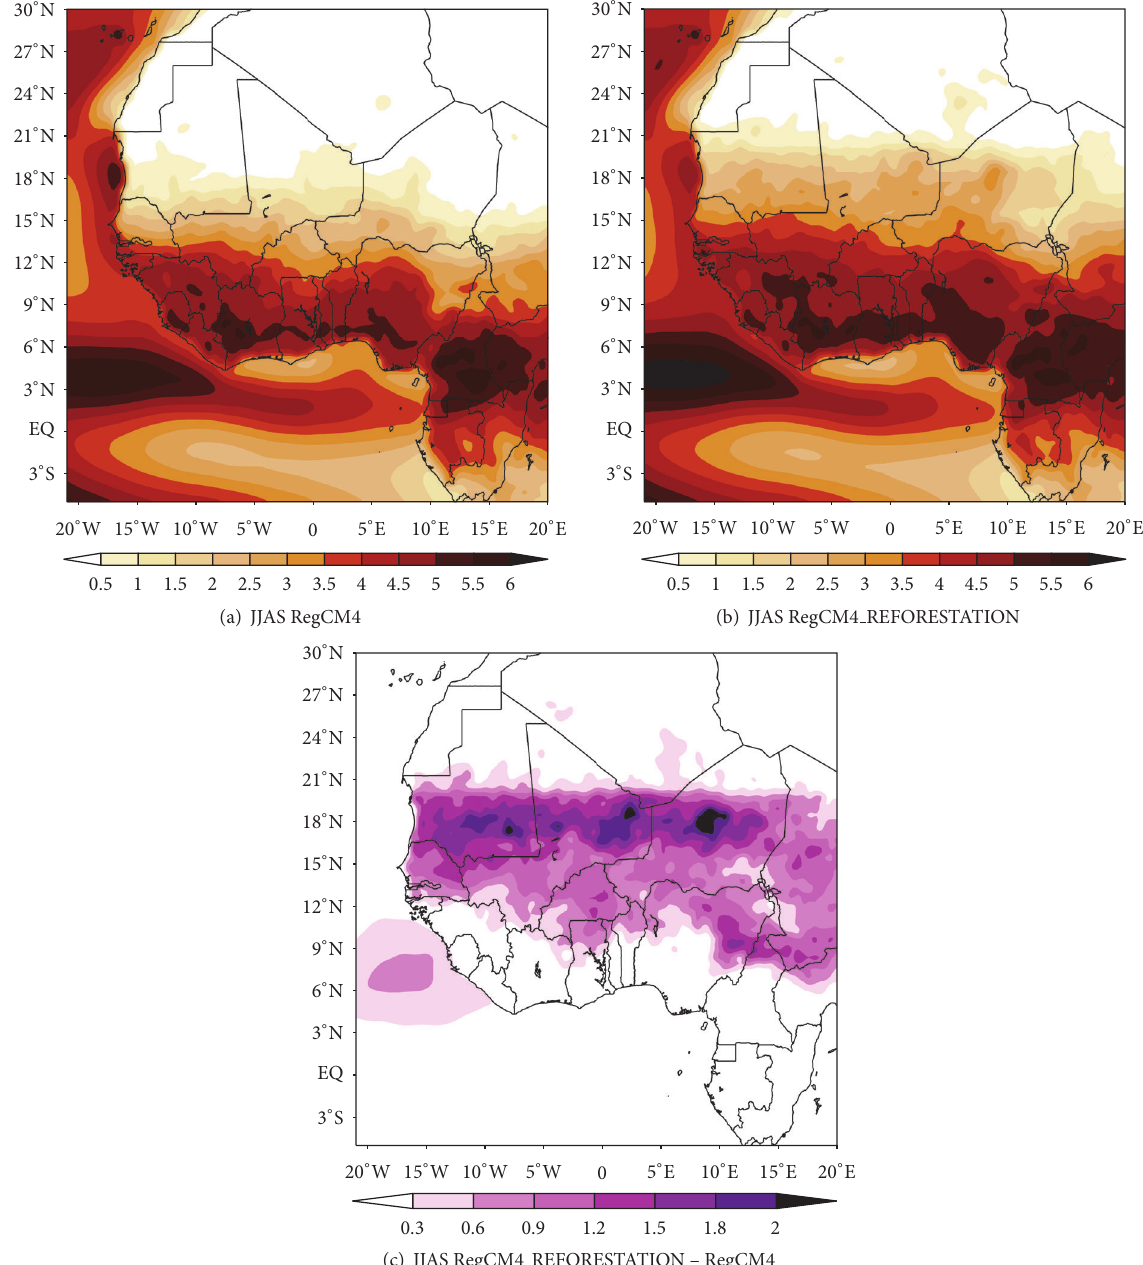
Figure 5: Mean summer evapotranspiration (cg/m 2 /s) averaged from 2003 to 2009 over West Africa for both runs and their difference.